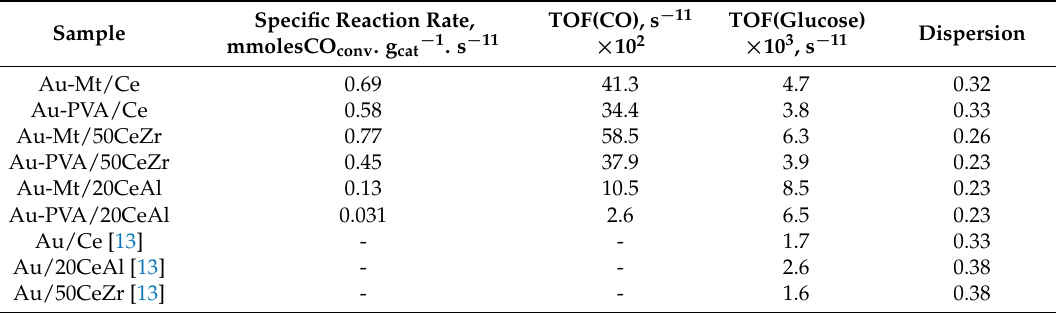
Table 2. Catalyst’ specific activity and gold particles